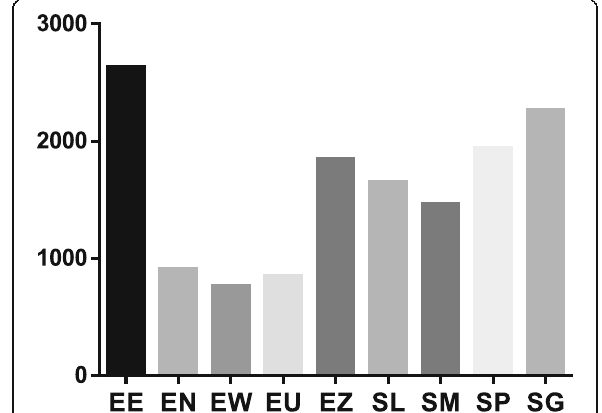
Fig. 3 The mean MIC in mg/ml of the acetone leaf extracts of the nine plants against six different bacterial species. EE =